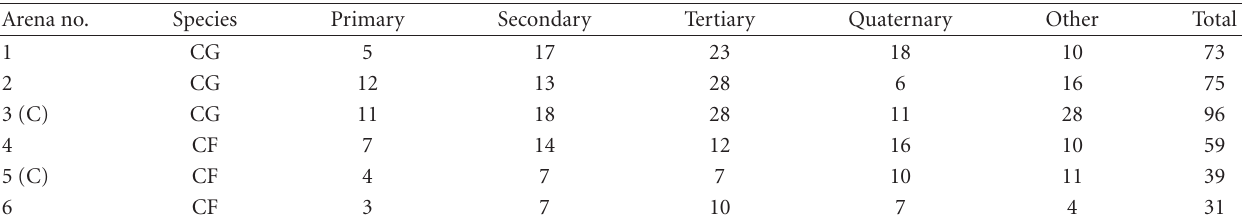
Table 1: Number of tunnels in each foraging arena (C: control arenas without wood; CG: Coptotermes gestroi , CF: Coptotermes formosanus ). Arena no.